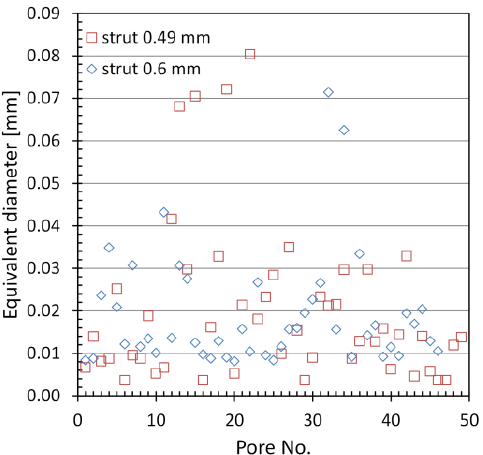
Figure 5. Graphs of the changes in the equivalent diameter of the struts at their height.